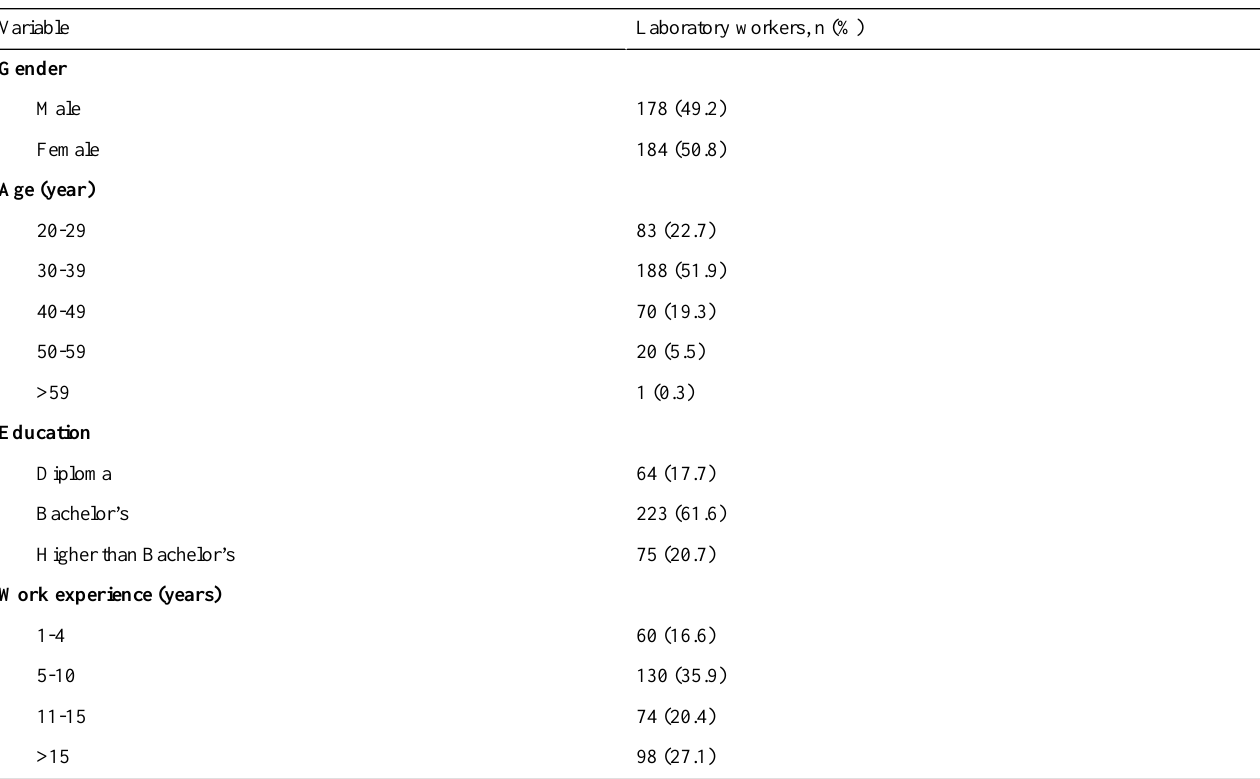
Table 1. Sociodemographic characteristics of laboratory workers (N=362).